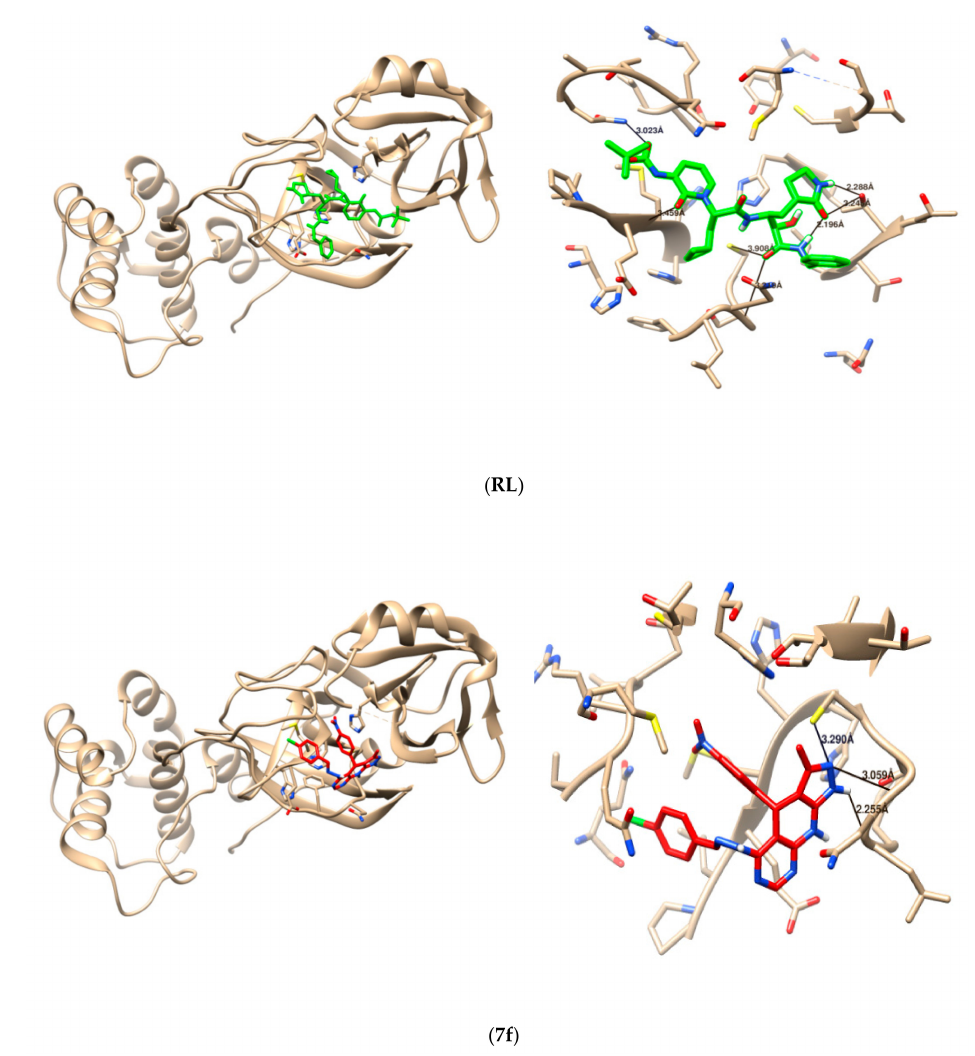
Figure 4. 3D interaction ( left ), and hydrogen bond formation ( right ), between reference ligand ( RL ), and tested compound 7f with 6Y2F